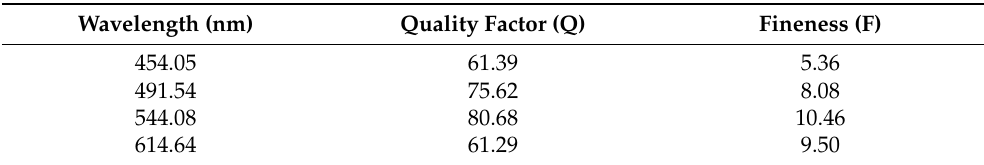
Table 3. Calculation of the quality factor (Q) and fineness (F) of the ZnO:K structure studied as a resonant